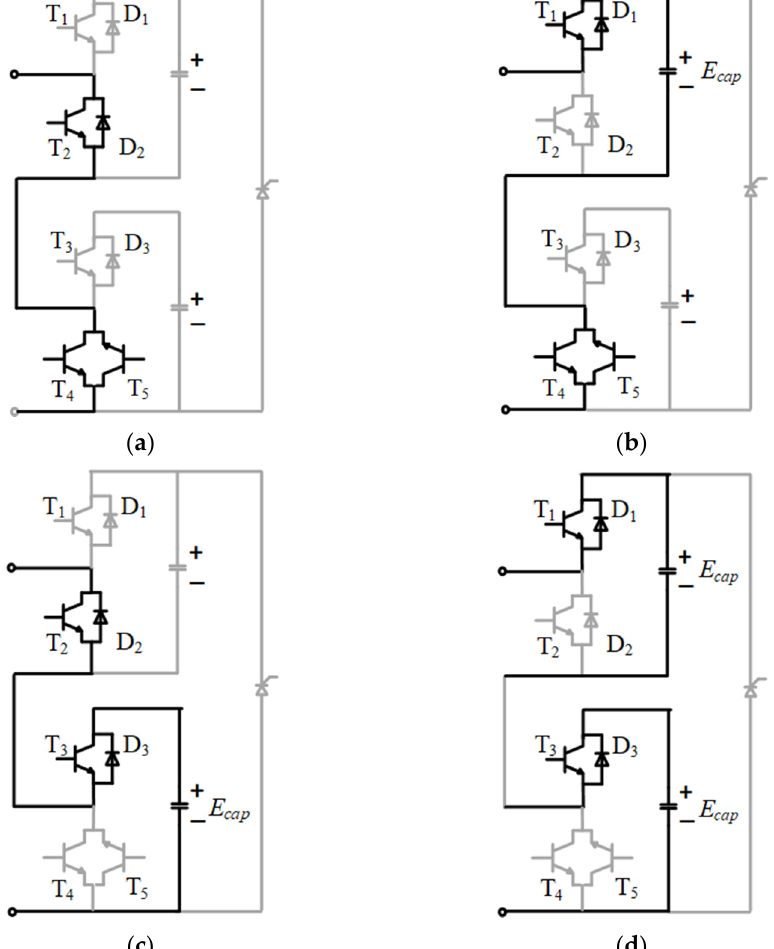
Figure 5. Operation of the BHBSM during the normal state ( a ) 0 [V], ( b , c ) 1 E cap [V], and ( d ) 2 E cap [V] per cell.